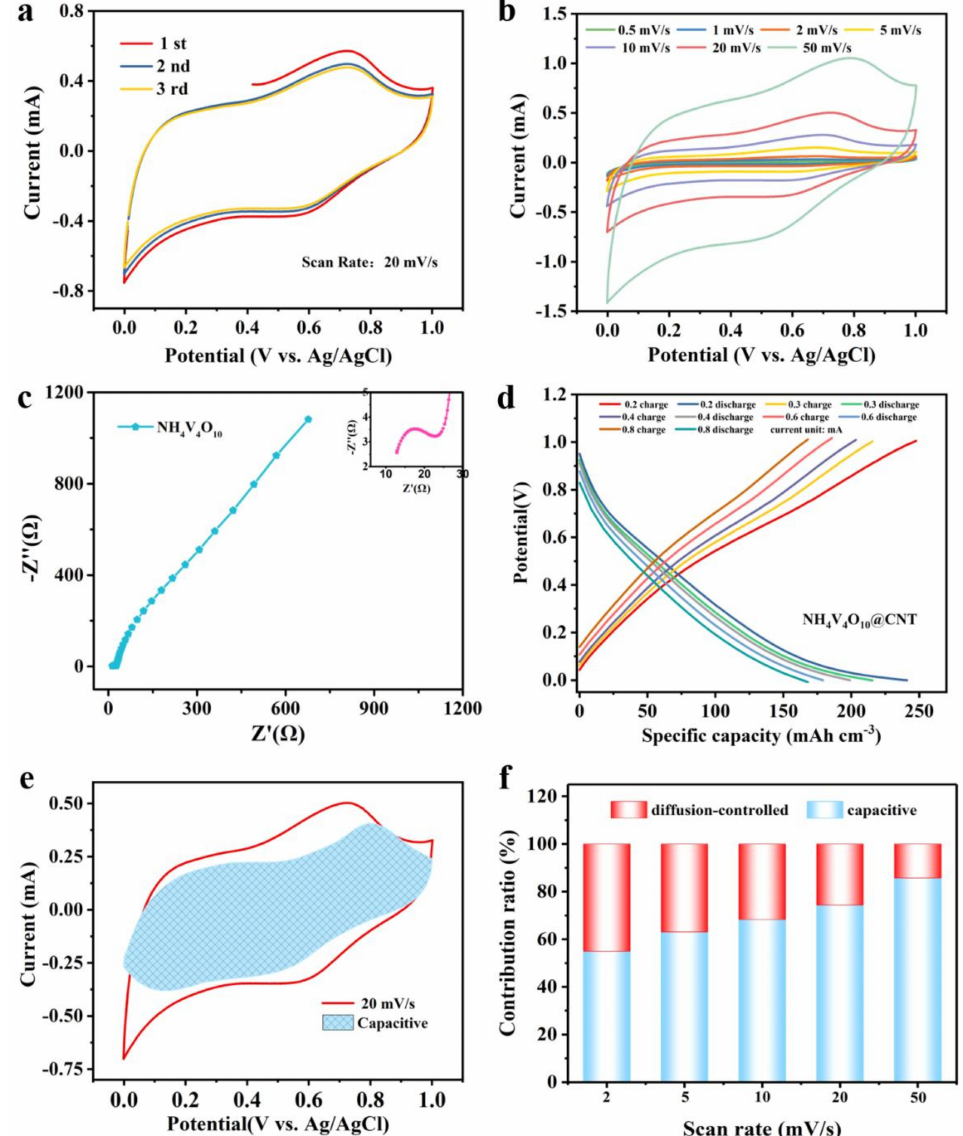
Figure 4. Electrochemical performance of NH 4 V 4 O 10 @CNT fiber with 1 mol L − 1 (NH 4 ) 2 SO 4 elec- trolyte in a three-electrode system: ( a ) the CV test of NH 4 V 4 O 10 @CNT fiber at a scan rate of 20 mV s − 1 ; ( b ) the CV test of NH 4 V 4 O 10 @CNT fiber at different scan rates; ( c ) the EIS curve of NH 4 V 4 O 10 @CNT fiber; ( d ) galvanostatic charge/discharge measurement of NH 4 V 4 O 10 @CNT fiber at different current densities; ( e ) CV curves with the capacitive fraction shown by the shaded area at a scan rate of 20 mV s − 1 ; ( f ) electrode dynamics of NH 4 V 4 O 10 @CNT fiber with the percent of pseudocapacitive contribution at different scan